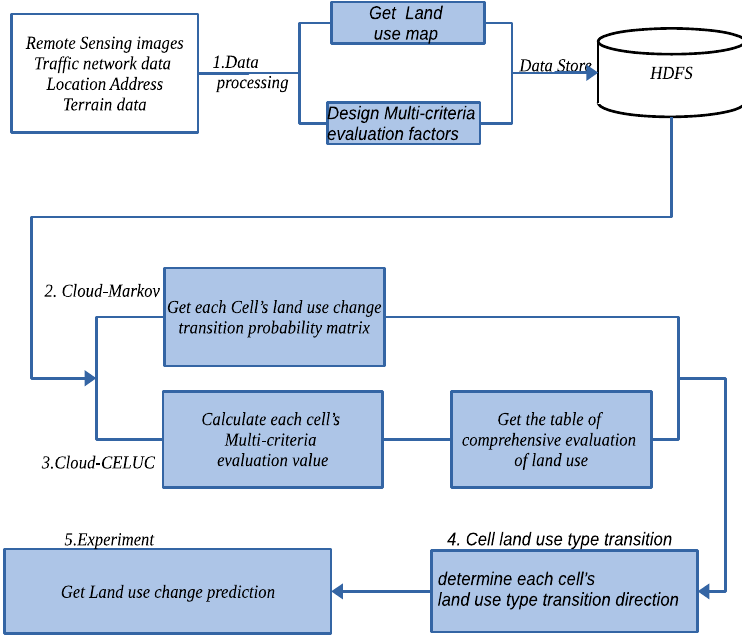
Figure 4. Parallel Cellular Automata-Markov (CA-Markov) flow.